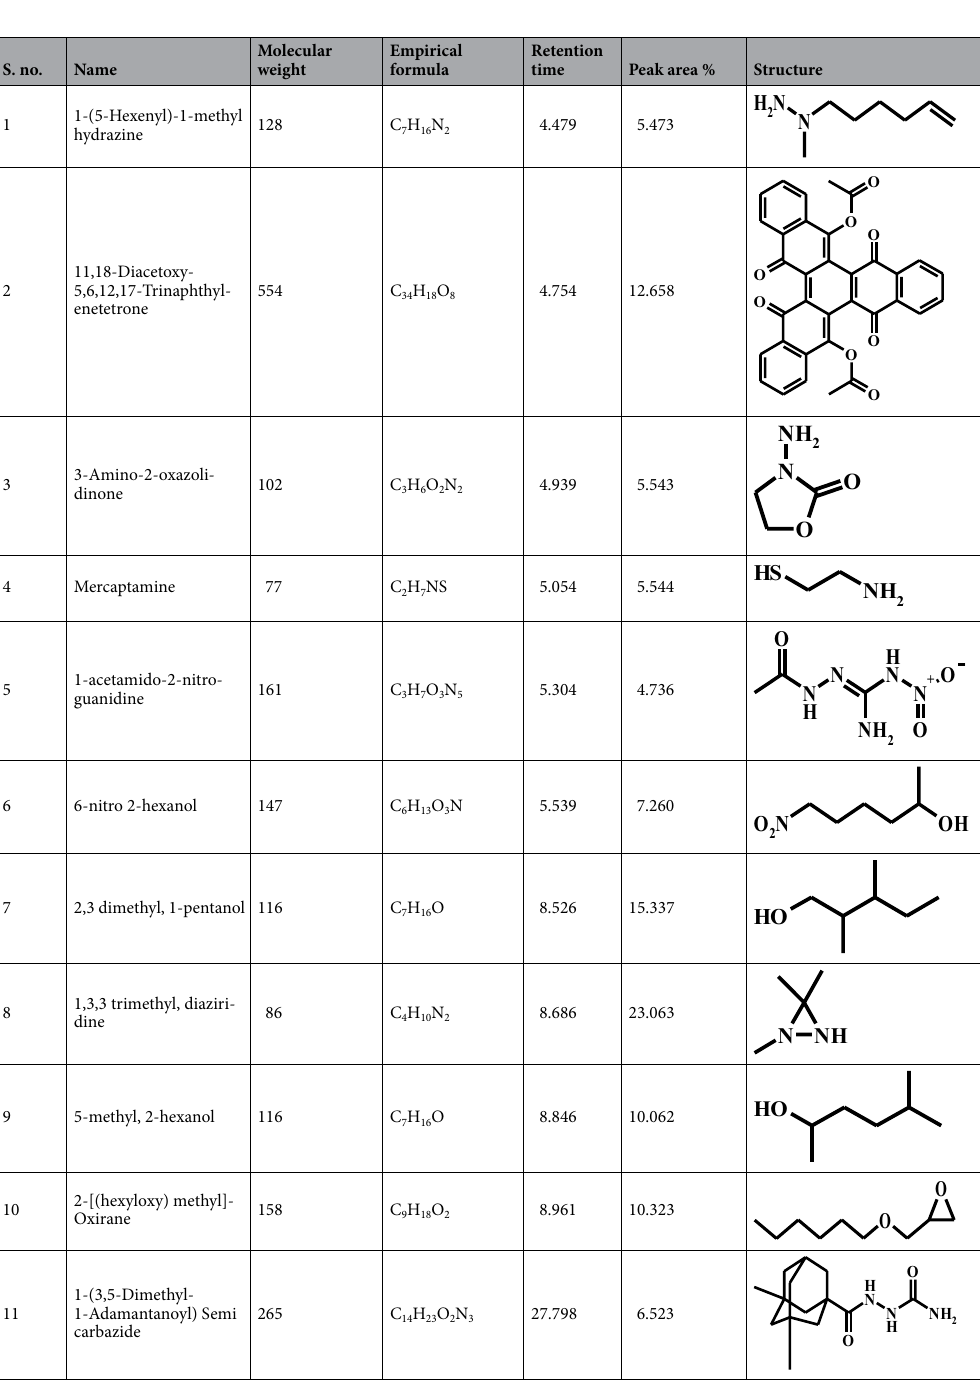
Table 2. GCMS profile of compounds present in mangostan peel extract